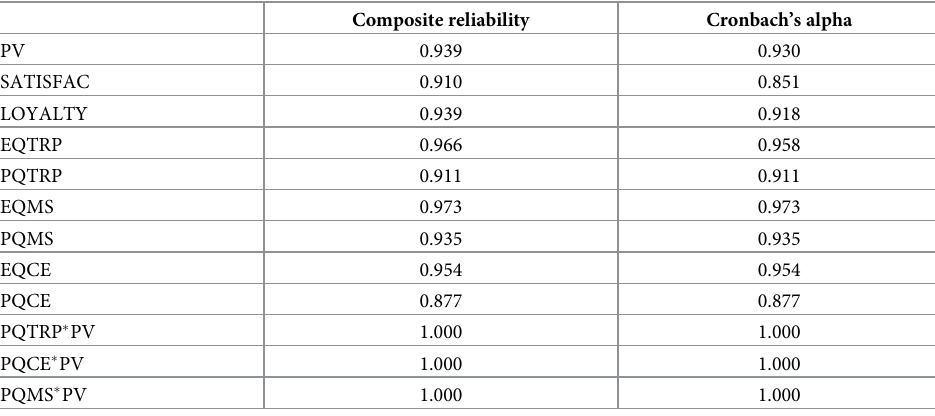
Table 6. Composite reliability and cronbach’s alpha.